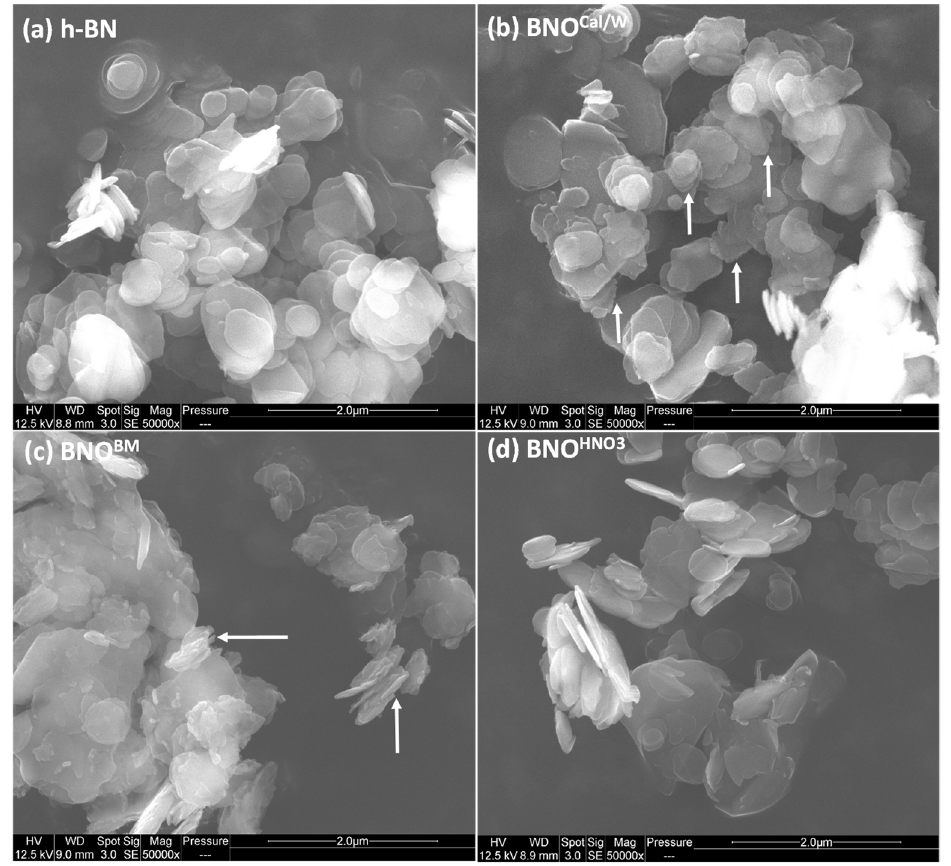
Figure 7. SEM images of ( a ) h-BN, ( b ) BNO Cal/W , ( c ) BNO BM , and ( d ) BNO HNO3 samples. Magnifica- tion: 50,000X, scale bar = 2 µm, and arrows indicate the evolution of the edges of the sheets . To evaluate the size of the h-BN particles, we measured from these SEM images the diameters of 100 platelets for each sample (Figure 8). Most particles of h-BN were in the range of 0.1 to 0.5 µm, and a small number of platelets had a diameter greater than 1 µm.